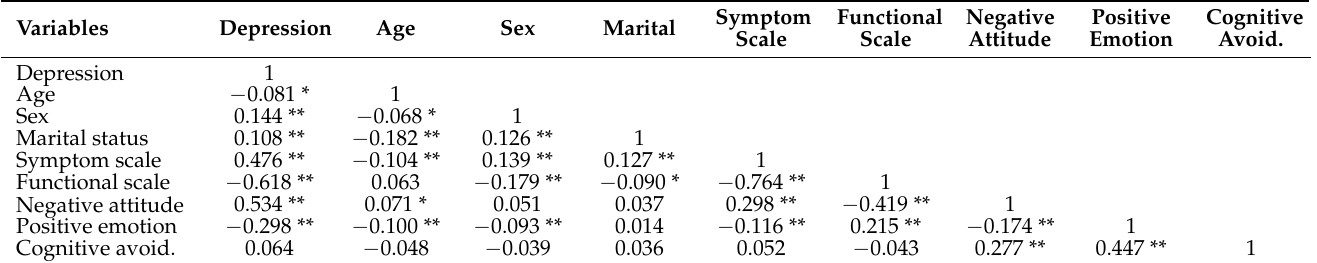
Table 2. Correlations across depressive symptoms and study variables.